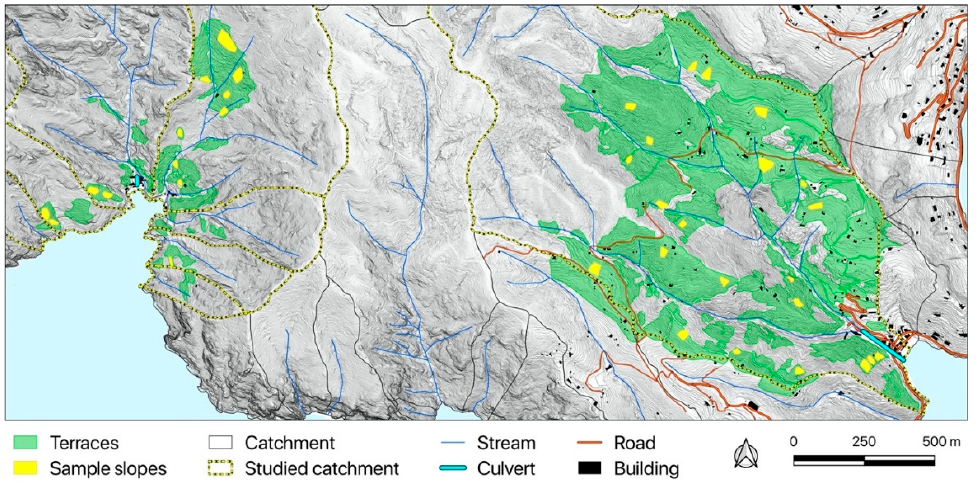
Figure 9. The detected terraces after the application of SKF, LUC and LIHA analyses. The yellow areas indicate the sample slopes used in the volume calculation.